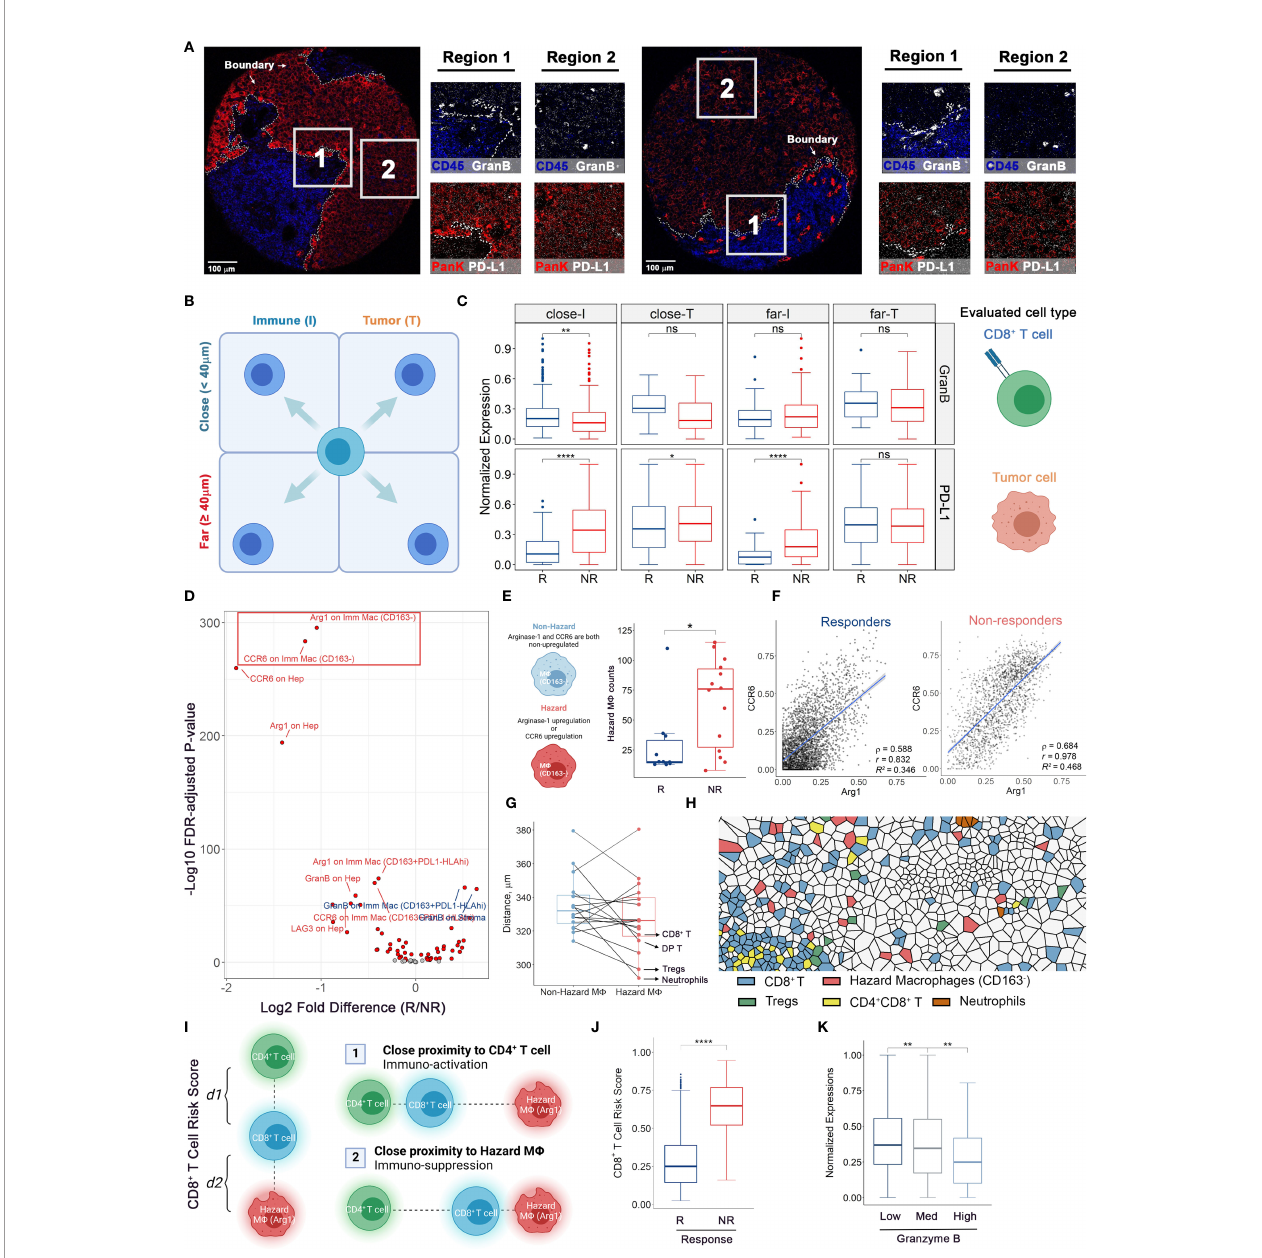
FIGURE 5 | Multicellular protein expressions at HCC/hepatocytes-immune border reveal associations to immune-therapy outcomes. (A) Color overlays of lineage proteins covering Pan-Keratin and CD45 (red and blue) and functional markers covering PD-L1 and Granzyme B (white) in whole tissue core and subregions. (B, C) Protein expression analytical strategy. For compartmentalized cores (n = 2 from R and n = 6 from NR), functional marker expressions on target cells were examined adjacent and remote to HCC/hepatocytes-immune border and truncated to treatment response criteria for comparisons. (D) Volcano plot showing the comparison results of marker intensities on various cell types in mixed cores (n = 10 from R and n = 8 from NR, same for the rest legends). Red dots: FDR-adjusted P values < 0.01. Text colors indicate whether the mean marker expression was higher in non-responders (red) or responders (blue). (E) Hazard macrophage was de fi ned such that at least one protein of CCR6 and Arg1 was upregulated on CD163 - macrophages. (F) Correlation plots showing the co-expression pattern of CCR6 and Arg1 on CD163-negative macrophages. (G) Quanti fi cations of shortest distances between two macrophage subtypes and other cell types. (H) Voronoi tessellation map highlighted for hazard-, non-hazard macrophages and B cells. (I) Diagram of CD8 + T cell RiskScore . Denote each CD8 + T cell to its nearest hazard macrophages as d1 and to its nearest CD4 + T cell as d2 , thus the RiskScore is formally computed by taking the proportion of d2 to the combined distance of d1 and d2 . (J) RiskScore on per-cell basis for responders (evaluable n = 8) and non-responders (evaluable n = 12). (K) Normalized Granzyme B expressions on per- CD8 + T cell basis for low-, medium-, and high- RiskScore groups. P values were computed by two-tailed Wilcoxon ’ s rank-sum test with adjustment for multiple comparisons (FDR). *p value < 0.05, **p value < 0.01, ****p value < 0.0001. ns, not signi fi